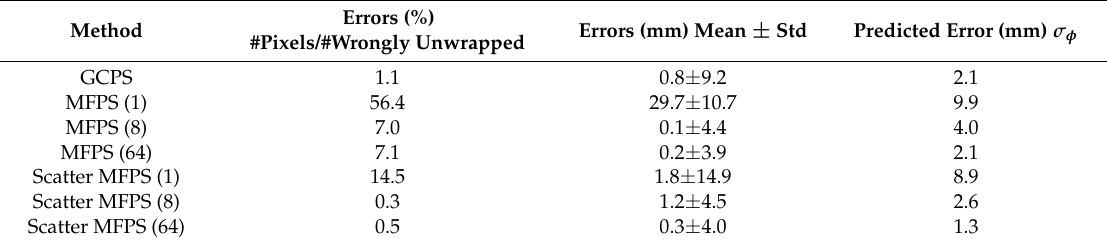
Table 2. Results from λ 2 = 1.1 m. We show the results for the intermediate steps in the MFPS algorithm, i.e., the frequencies 1, 8 and 64. Description of the columns is given in Table 1.